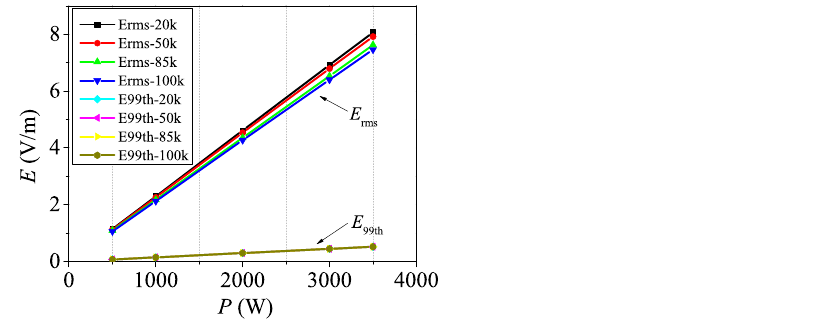
Figure 7. Curves of the internal E -field strength of the human body versus the output power at various frequencies.